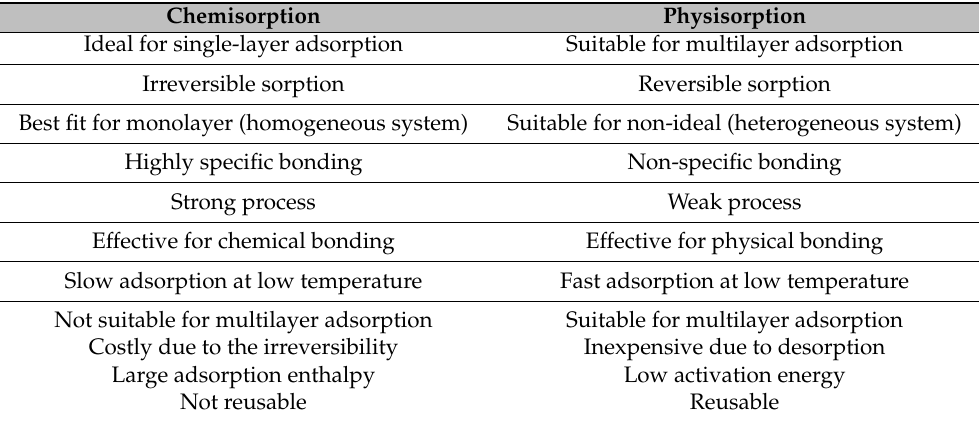
Table 1. Merits and demerits of the chemisorption and physisorption. Chemisorption Physisorption Ideal for single-layer